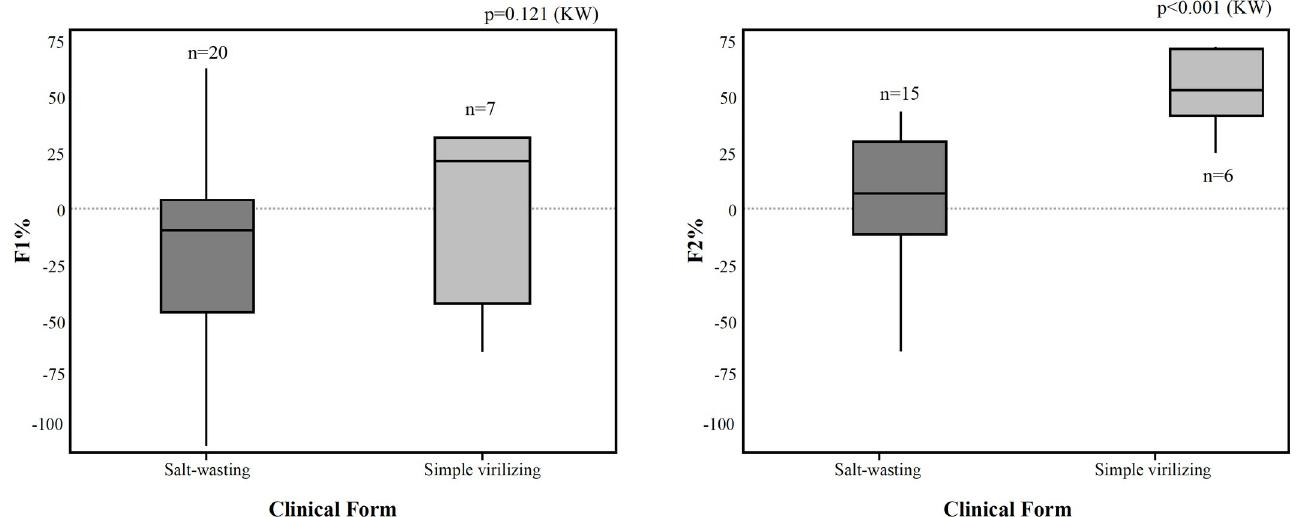
Fig 3. Boxplots. Distribution of dexamethasone suppressed cortisol (F1% and F2%) of 21-OHD-subjects according to their clinical form. n = 27. Any percentage reduction was considered a positive suppressive response. F1% = 100 - (F 2 hours x 100/F basal ); F2% = 100 - (F 4 hours x 100)/F 2 hours ); 21-OHD: 21-hydroxylase.